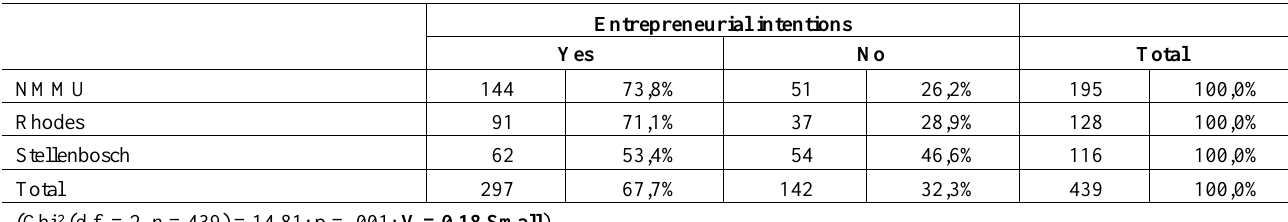
Entrepreneurial intentions